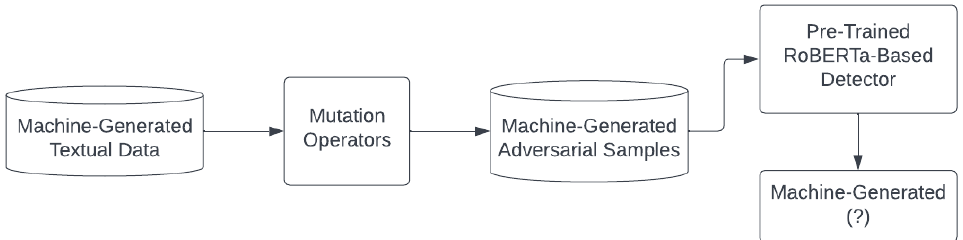
Figure 1. Adversarial attack of the pretrained RoBERTa-based